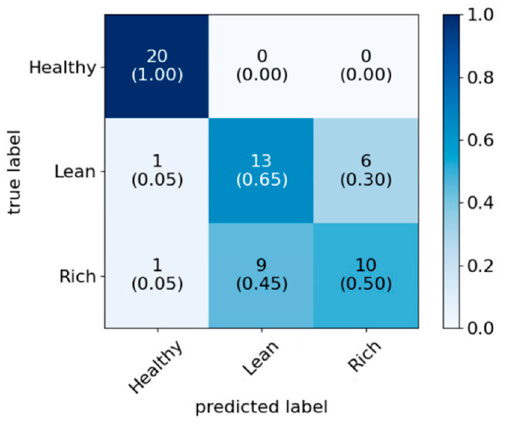
Figure 14. Model 3—confusion matrix for AFR variation data.